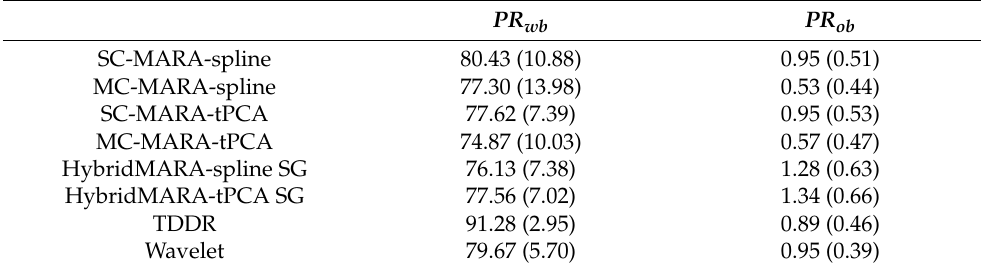
Table 1. Mean (std) Power Ratio at the passband ( PR wb ) and stopband ( PR ob ) in the f = [ 0.01 − 0.2 ] Hz range across subjects and measurement channels. The leftmost column indicates the adopted MA reduction algorithm prior to the BPF step.